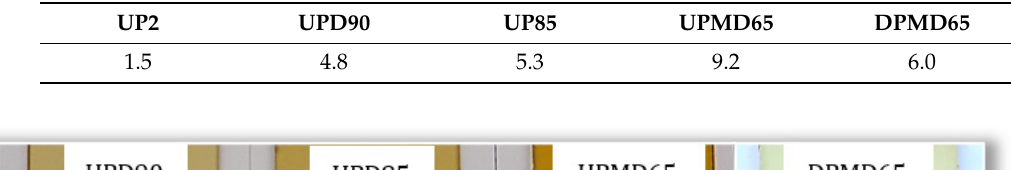
Table 8. Color values of the uncured UPs (GARDNER).